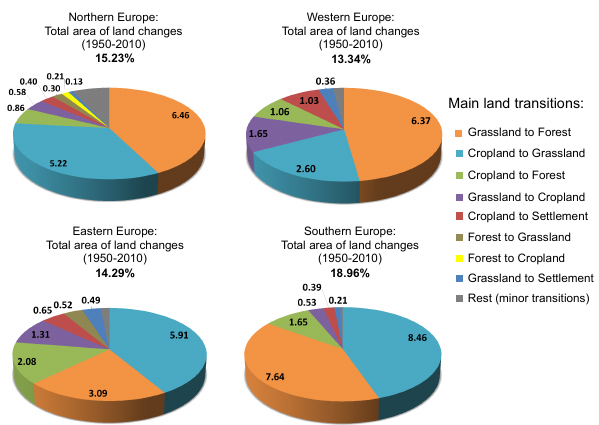
Fig. 6. Main land transitions and relative amount of land changes per region for 1950–2010.